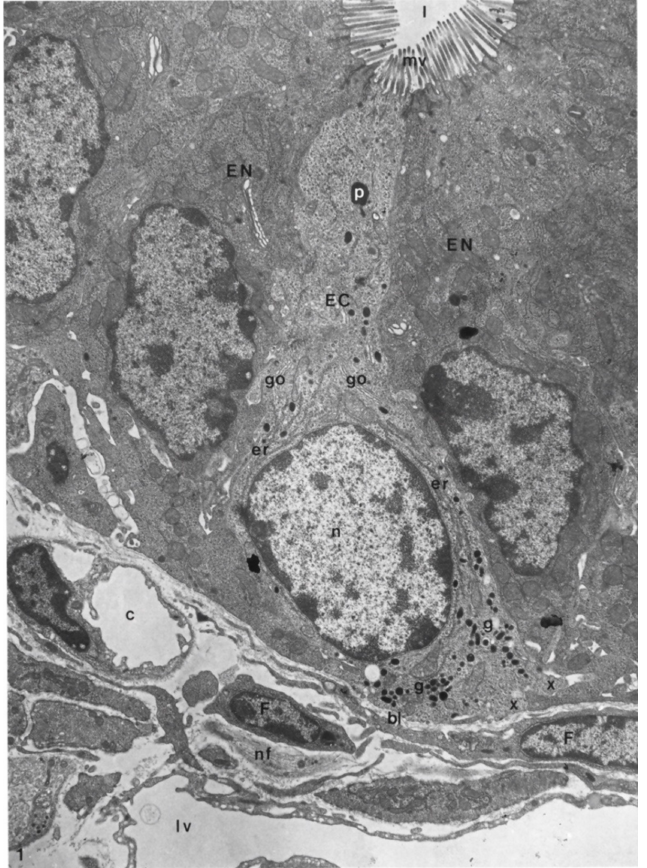
Figure 8. Longitudinal section of an enterochromaffin cell from the basal lamina to the lumen of a duodenal crypt, in which it is possible to recognize a fenestrated capillary, fibroblast, lymph vessel, and nerve fibers. Moreover, it is also possible to highlight the presence of rough endoplasmic reticu- lum, secretory granules, Golgi complexes, microvilli, phagosome, and basal cytoplasmic extensions of the enterochromaffin cell. EC: enterochromaffin cell; bl: basal lamina; l: lumen; c: capillary; nf: nerve fibers; lv: lymph vessel; F: fibroblasts; EN: enterocytes granules; g: secretory granules; go: Golgi complexes; mv: microvilli; p: phagosome; x: basal cytoplasmic extension. X 9.600. The Figure is obtained from Wade et al., (1985). Reprinted by permission from Springer Nature Customer Service Centre GmbH: Springer Nature, Cell and Tissue Research (License Number 5232430326152, 19 January 2022)